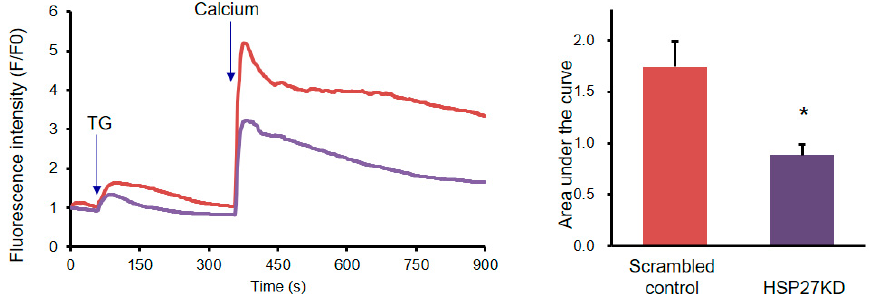
Figure 6. HSP27 mediated TG-induced intracellular calcium mobilization. ( a ) Representative intracellular Ca 2+ ([Ca 2+ ]i) measurement in scrambled control and HSP27KD cells. Each trace is the mean [Ca 2+ ]i measurement of at least 100 cells. The SOCE amplitude indicates the rise of [Ca 2+ ]i in the replenishment of [Ca 2+ ]o from 0 to 2 mM. Arrow, adding 2 μ M thapsigargin (TG). ( b ) Quantitative